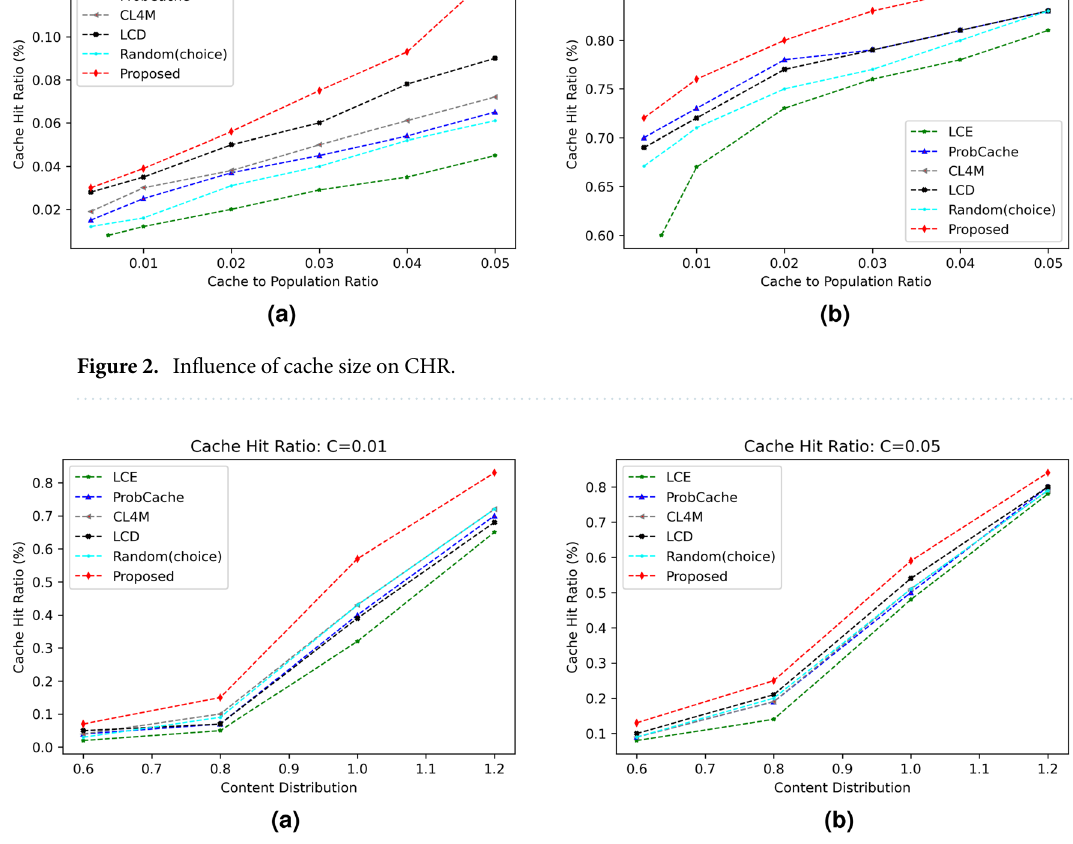
Figure 3. Influence of content distribution (α) on CHR.